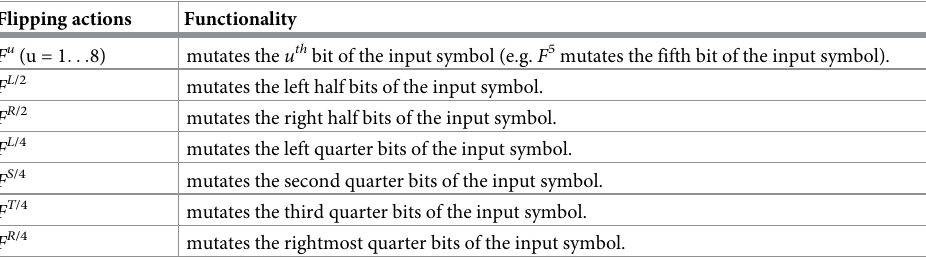
Table 2. The F -TAB: 14 bitwise-distortion